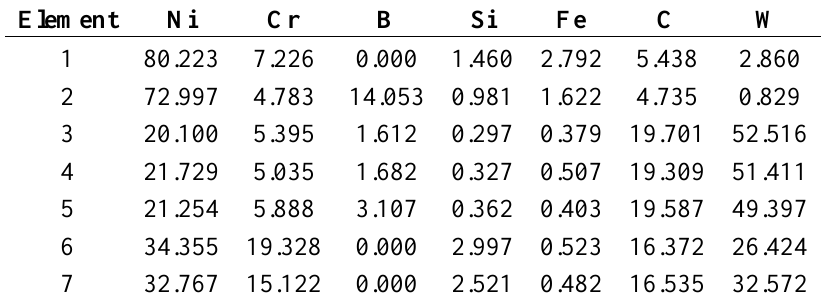
Figure 9. Elemental mapping of the acicular constituent of sample D ( a ) BEI; ( b ) Ni; ( c ) Cr; ( d ) B; ( e ) Si; ( f ) Fe; ( g ) C; ( h ) W. Table 5. The EPMA results of points on Figure 8b. Composition is shown in %.